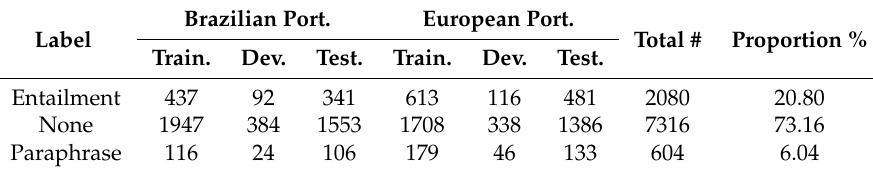
Table 2. Frequency of the labels in the ASSIN corpus.